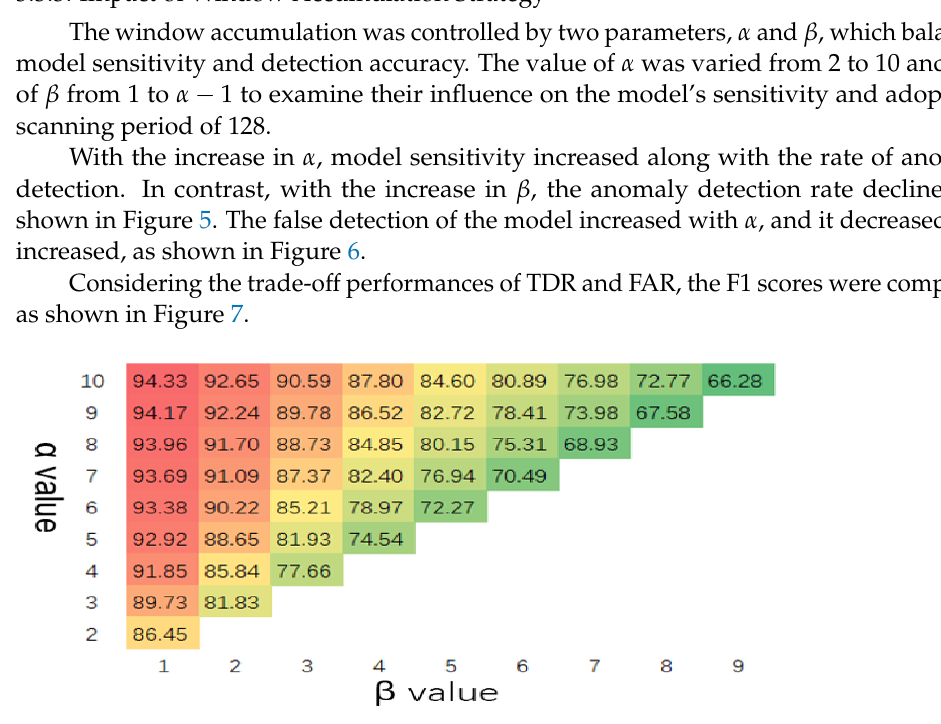
Figure 5. Threat detection rate(%) with different values of α and β (scanning period = 128 and channel width =